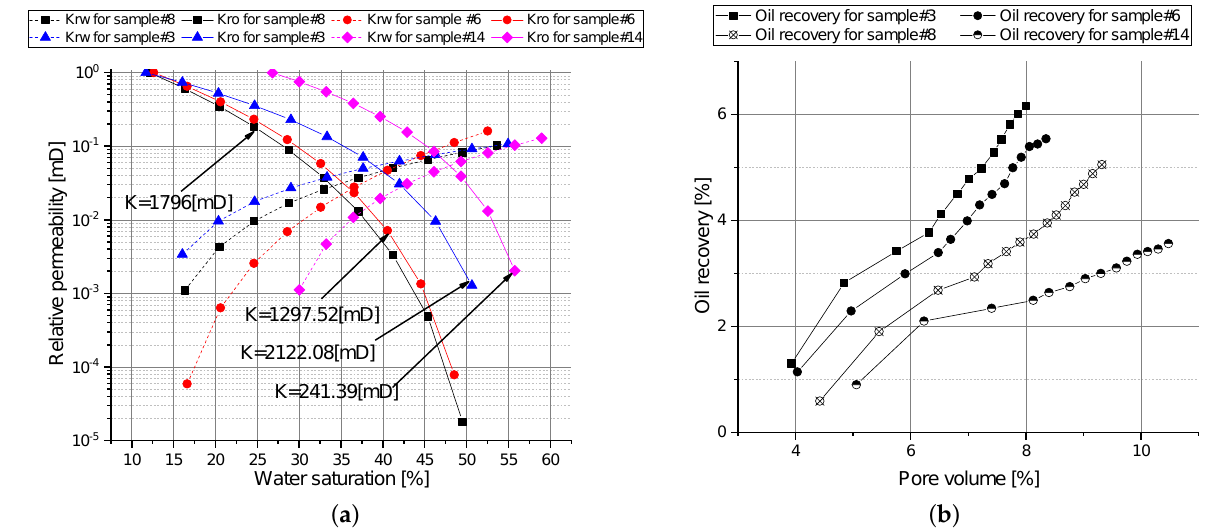
Figure 5. Relative permeability versus water saturation highlighting: ( a ) the impact of petrophysical properties on wetting and non-wetting phases and ( b ) oil recovery versus pore volume.